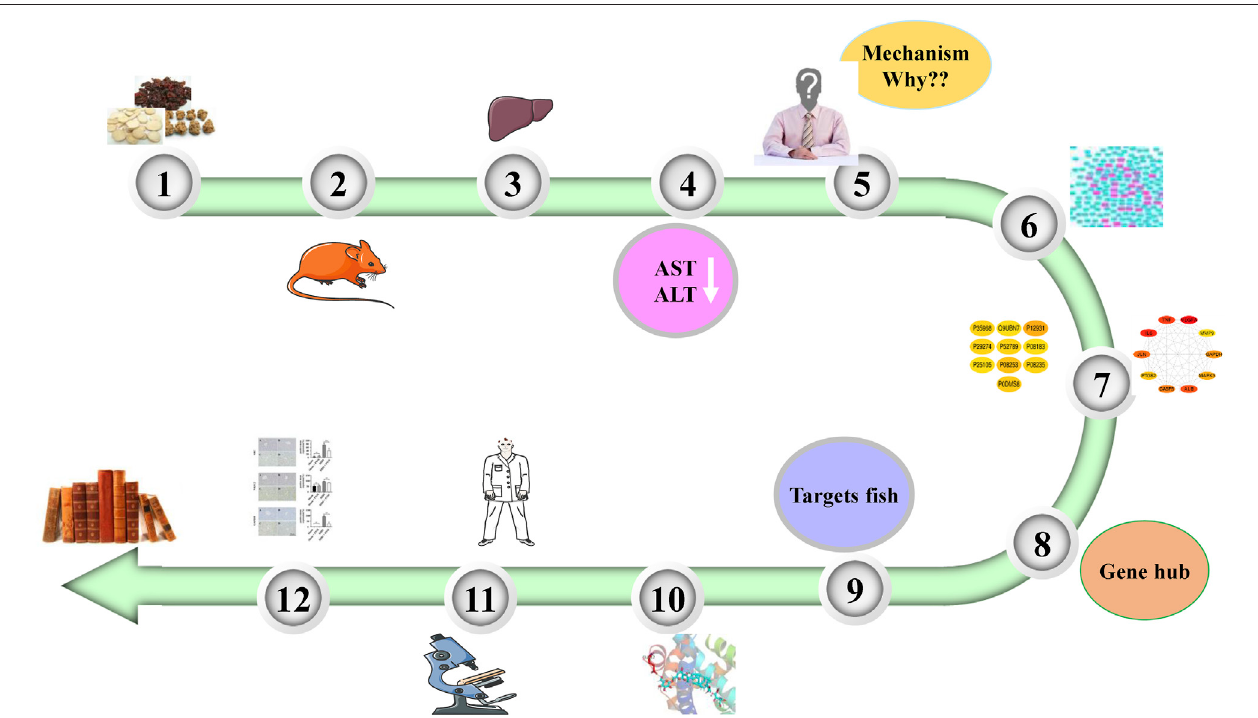
FIGURE 1 | Overall design of experiment. PNM can reduce the levels of AST and ALT in HIRI mice. Therefore, the molecular mechanism was explored by using network pharmacology. First, 20 Hub target genes were screened out, and then the molecular docking technology was used to make the active site of Hub target gene receptor form a complex with its corresponding small molecule ligand by hydrogen bond. Finally, NR3C2, SRC, and GAPDH were identi fi ed as the target genes and veri fi ed by